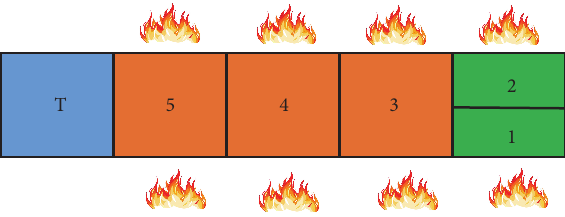
Figure 3: Schematic furnace zones disposition.